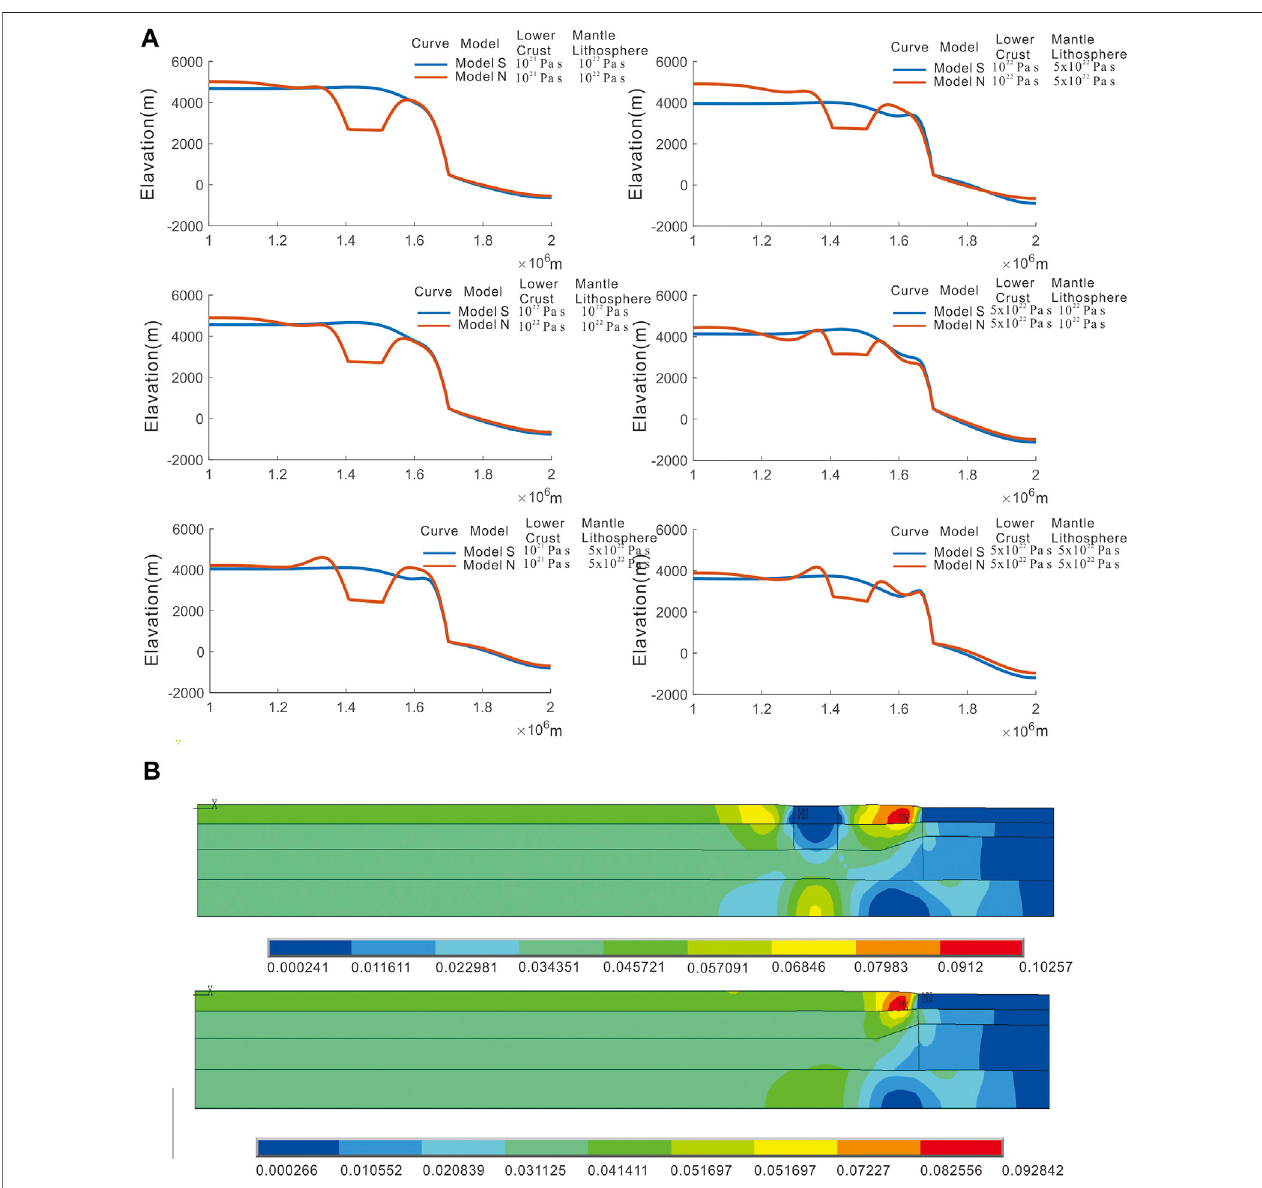
FIGURE8|(A) Comparedtothesimulationresults,thereisonlyasinglevariableRuoergairigidblock. (B) Comparingthestrainresultsofthesimulations,thereonly occurs a single variable Ruoergai rigid block. MX: Maximum strain; MN: Minimum strain; X: x direction.